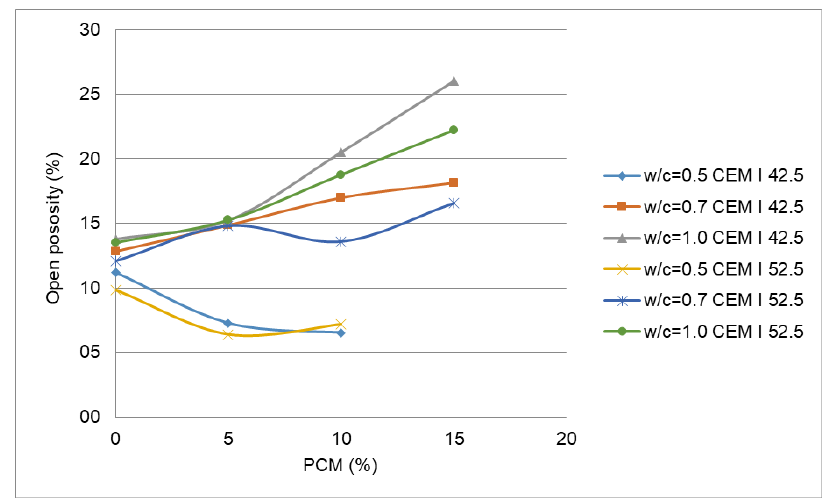
Figure 13. Open porosity in PX27 mortar mixtures.